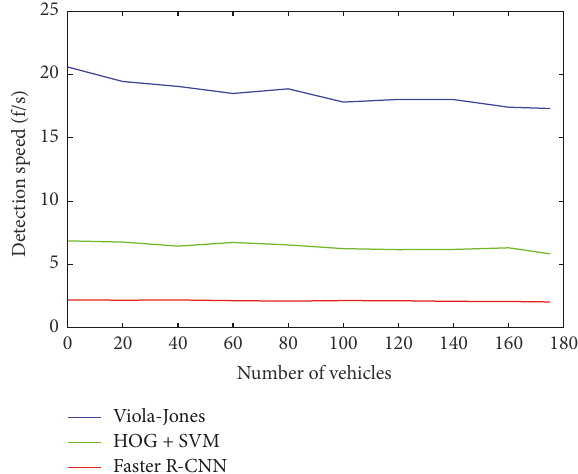
Figure 9: Sensitivity of detection speed to different detection load (tested on i7 CPU).